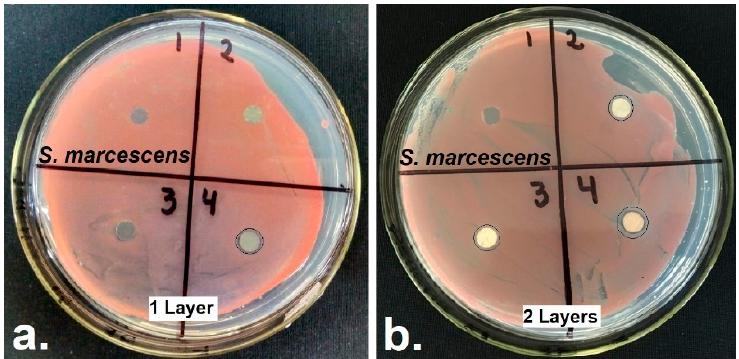
Figure 13. Inhibition zone of the PEEK (1), PEEK/Ag0.04 (2), PEEK/Ag0.08 (3) and PEEK/Ag0.12 (4) coated with one layer (a) and two layers (b) of silver with Serratia marcescens .